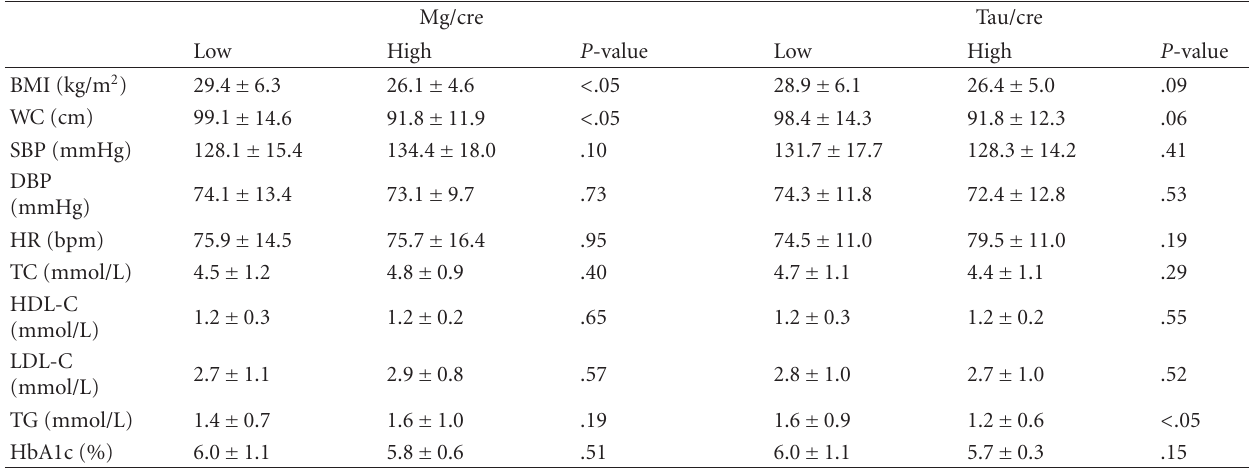
Table 4: MS risks according to urine levels of Mg/cre and Tau/cre.